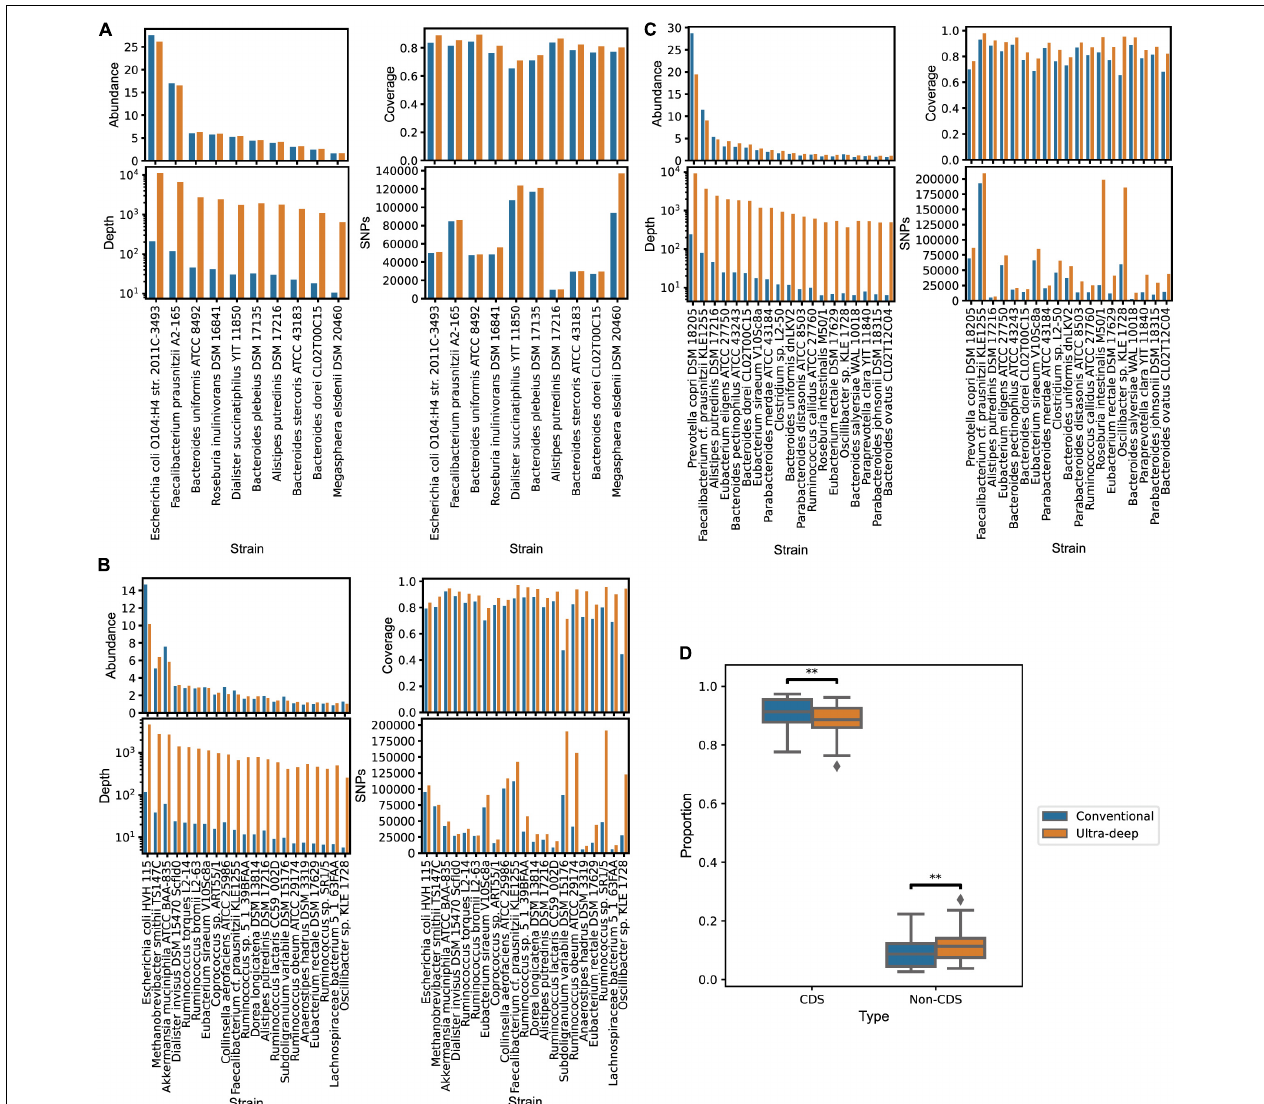
FIGURE 4 | Comparison of SNPs identified from ultra-deep sequencing and conventional sequencing data (6G). Relative abundances, sequencing coverages, depths, and SNP numbers of dominant strains are compared in sample D1 (A) , D2 (B) and D3 (C) . Orange bars represent the ultra-deep sequencing data and blue bars represent the conventional sequencing data. (D) The proportion of the cumulative CDS-SNPs and the non-CDS-SNPs of dominant strains from ultra-deep sequencing (Ultra-deep) and conventional sequencing data (Conventional).